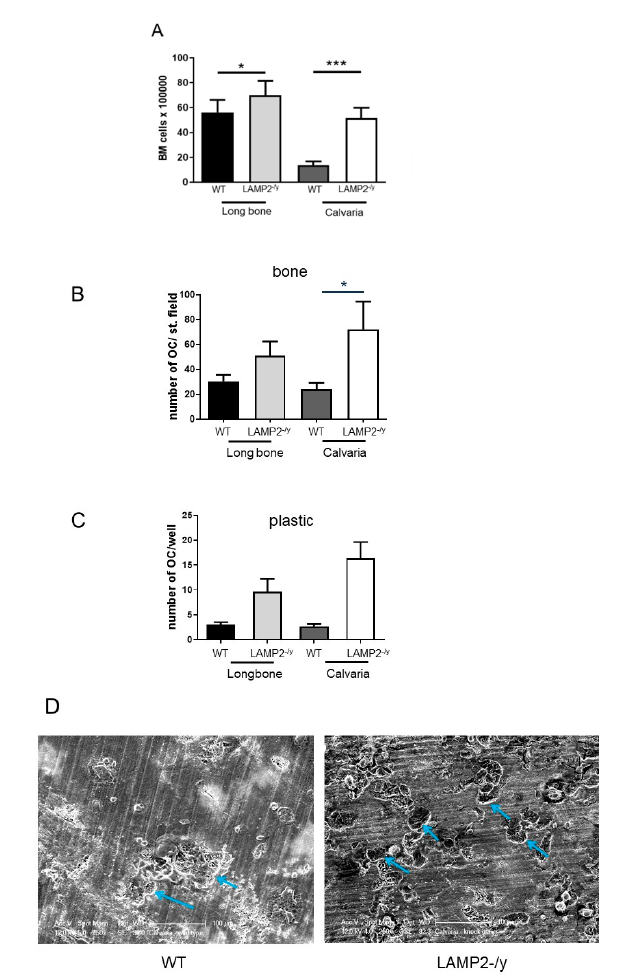
Figure 3. Osteoclast formation and activity in macrophage colony stimulating factor (M-CSF) and the receptor activator of nuclear kappa β ligand (RANKL) stimulated bone marrow cultures. ( A ) Number of isolated bone marrow cells from WT and LAMP-2-/y. Calvariae of LAMP-2-/y mice contained more marrow cells than the WT calvariae ( n = 6 ± SD, *** p < 0.001). The number of marrow cells isolated from LAMP-2-/y long bones is slightly higher than in WT long bones. ( n = 6 ± SD, * p < 0.05). Number of multinucleated cells, with more than 2 nuclei, formed after 6 days of culture with M-CSF and RANKL. Marrow cells were obtained from calvariae and long bones of wild type and LAMP-2 -/y mice. ( B ) The number of multinucleated cells generated on bone is shown. ( C ) The number of multinucleated cells generated on plastic ( n = 6 ± SEM, * p < 0.05). ( D ). Scanning electron micrographs of the resorptive activity of bone marrow cells from WT and LAMP-2-/y mice cultured on cortical bone slices. In both cultures resorption pits were formed (blue arrows).